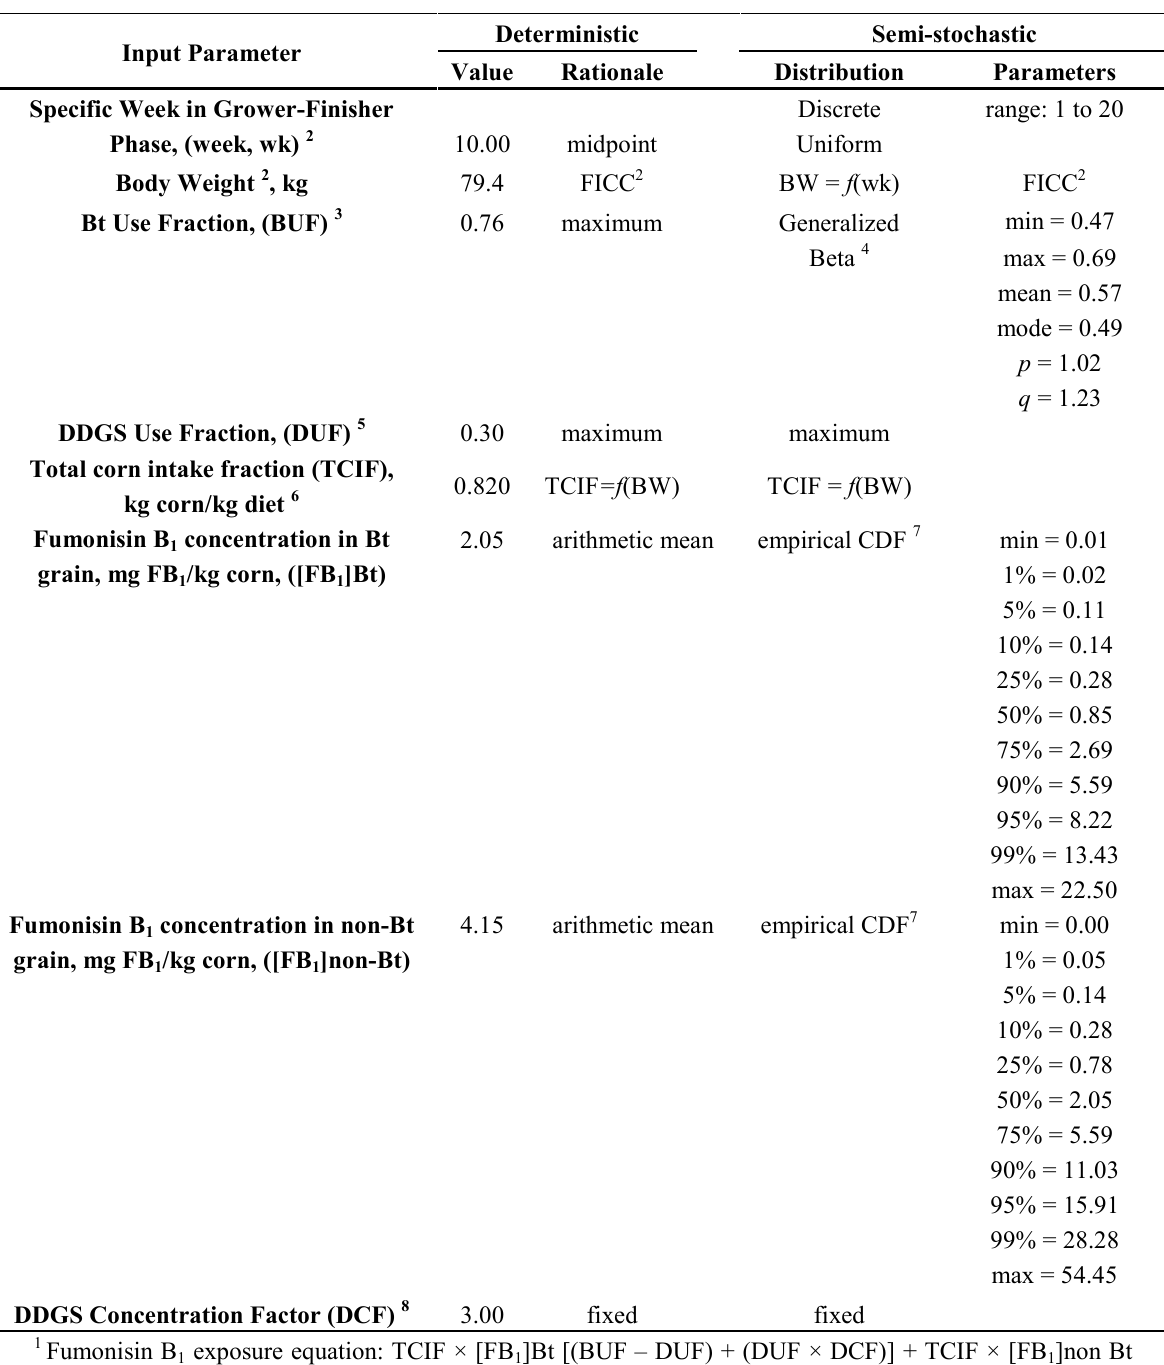
Table 1. Scenario 1 deterministic (single-point estimate) and semi-stochastic (probabilistic) analysis input assumptions for estimating long-term (20 weeks) exposure to fumonisin B in grower-finisher pig diets 1 1